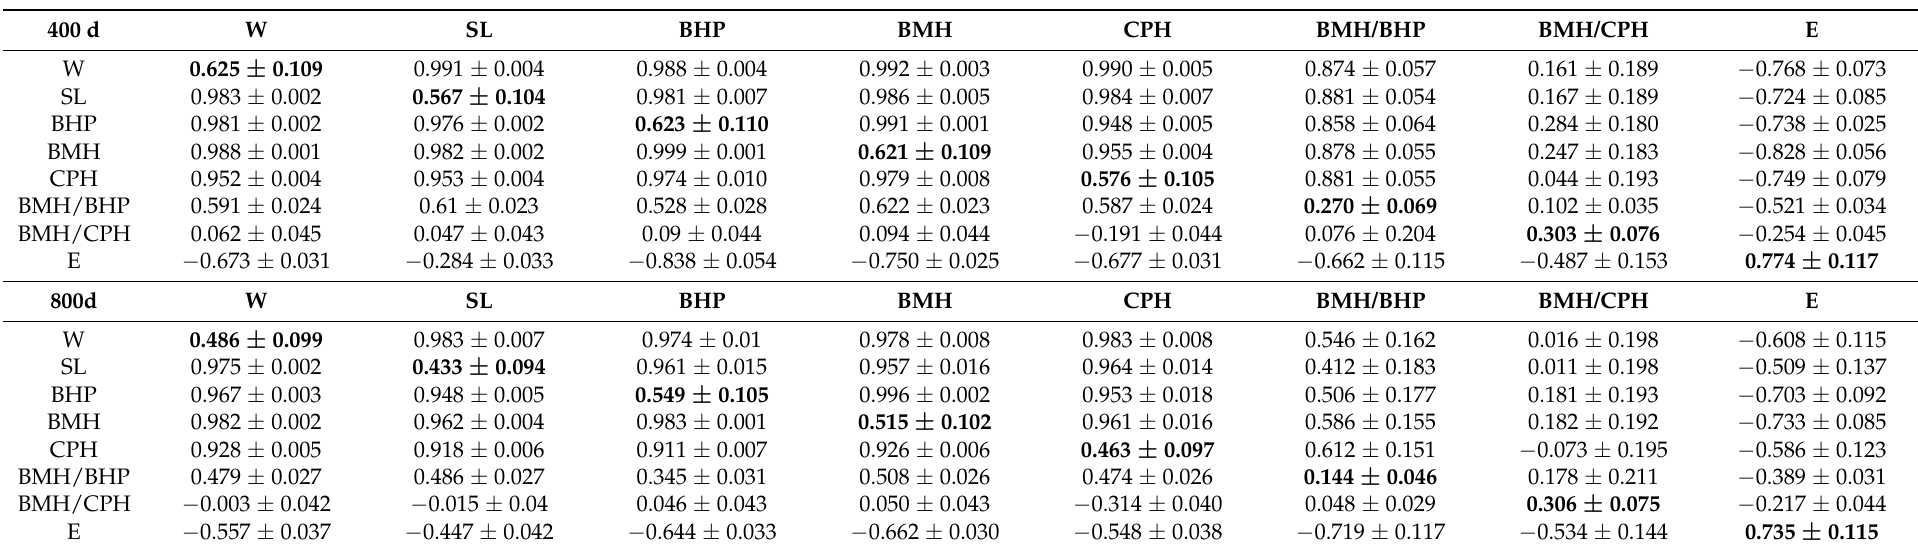
Table 2. Heritabilities (diagonal in bold), phenotypic correlations (below the diagonal) and genetic correlations (above the diagonal) for growth traits (weight (W) and standard length (SL)), heights (body height at the insertion of the pectoral fin (BHP), body maximum height (BMH) and caudal peduncle height (CPH)), height ratios (BMH/BHP and BMH/CPH) and ellipticity (E) at 400 days (d) (top) and 800 d